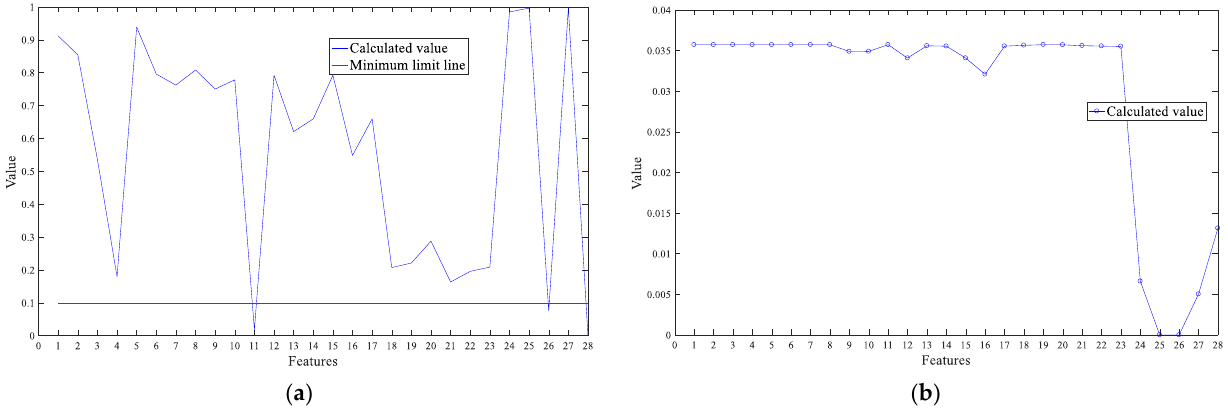
Figure 12. Value of each characteristic calculation index under Dataset 3: ( a ) Correlation; ( b ) robustness.